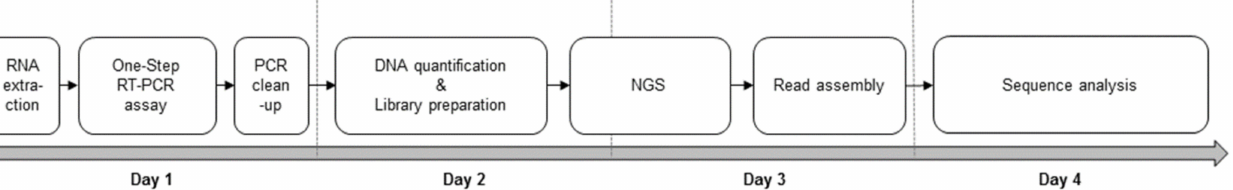
Figure 1. Workflow and turnaround time per set of 20 clinical respiratory